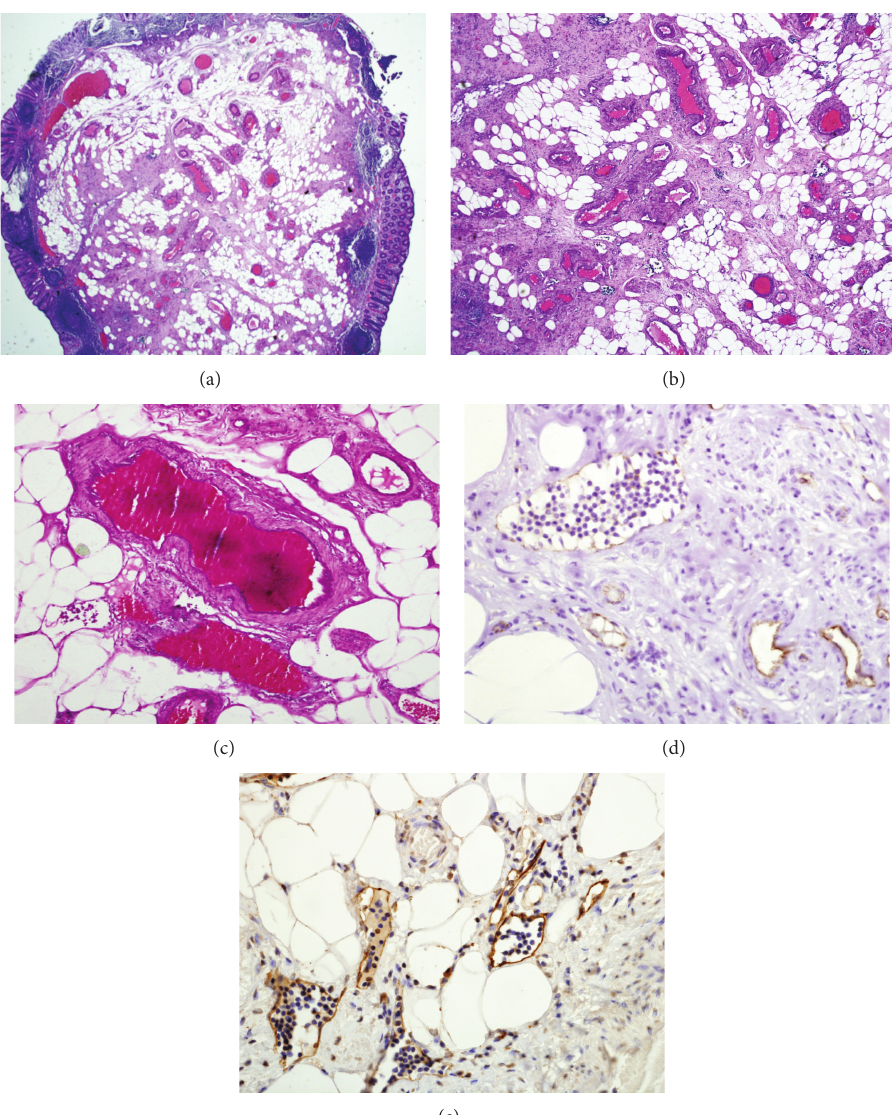
Figure 1: (a) and (b) show a colonic polypoid submucosal proliferation of mature adipose and fibrous tissue with blood and lymph vessels of different sizes (hematoxylin and eosin stained sections, (a) magnification × 20 and (b) magnification × 40). (c) Weigert’s stain for elastic fibers highlights the internal elastic lamina in arteries (magnification × 100). (d) CD31 stains endothelial cells from blood and lymph vessels (see large lymph vessel at upper right) (magnification × 400). (e) D2-40 stains the lymphatic endothelium while the blood vessels endothelial cells remain negative (magnification ×